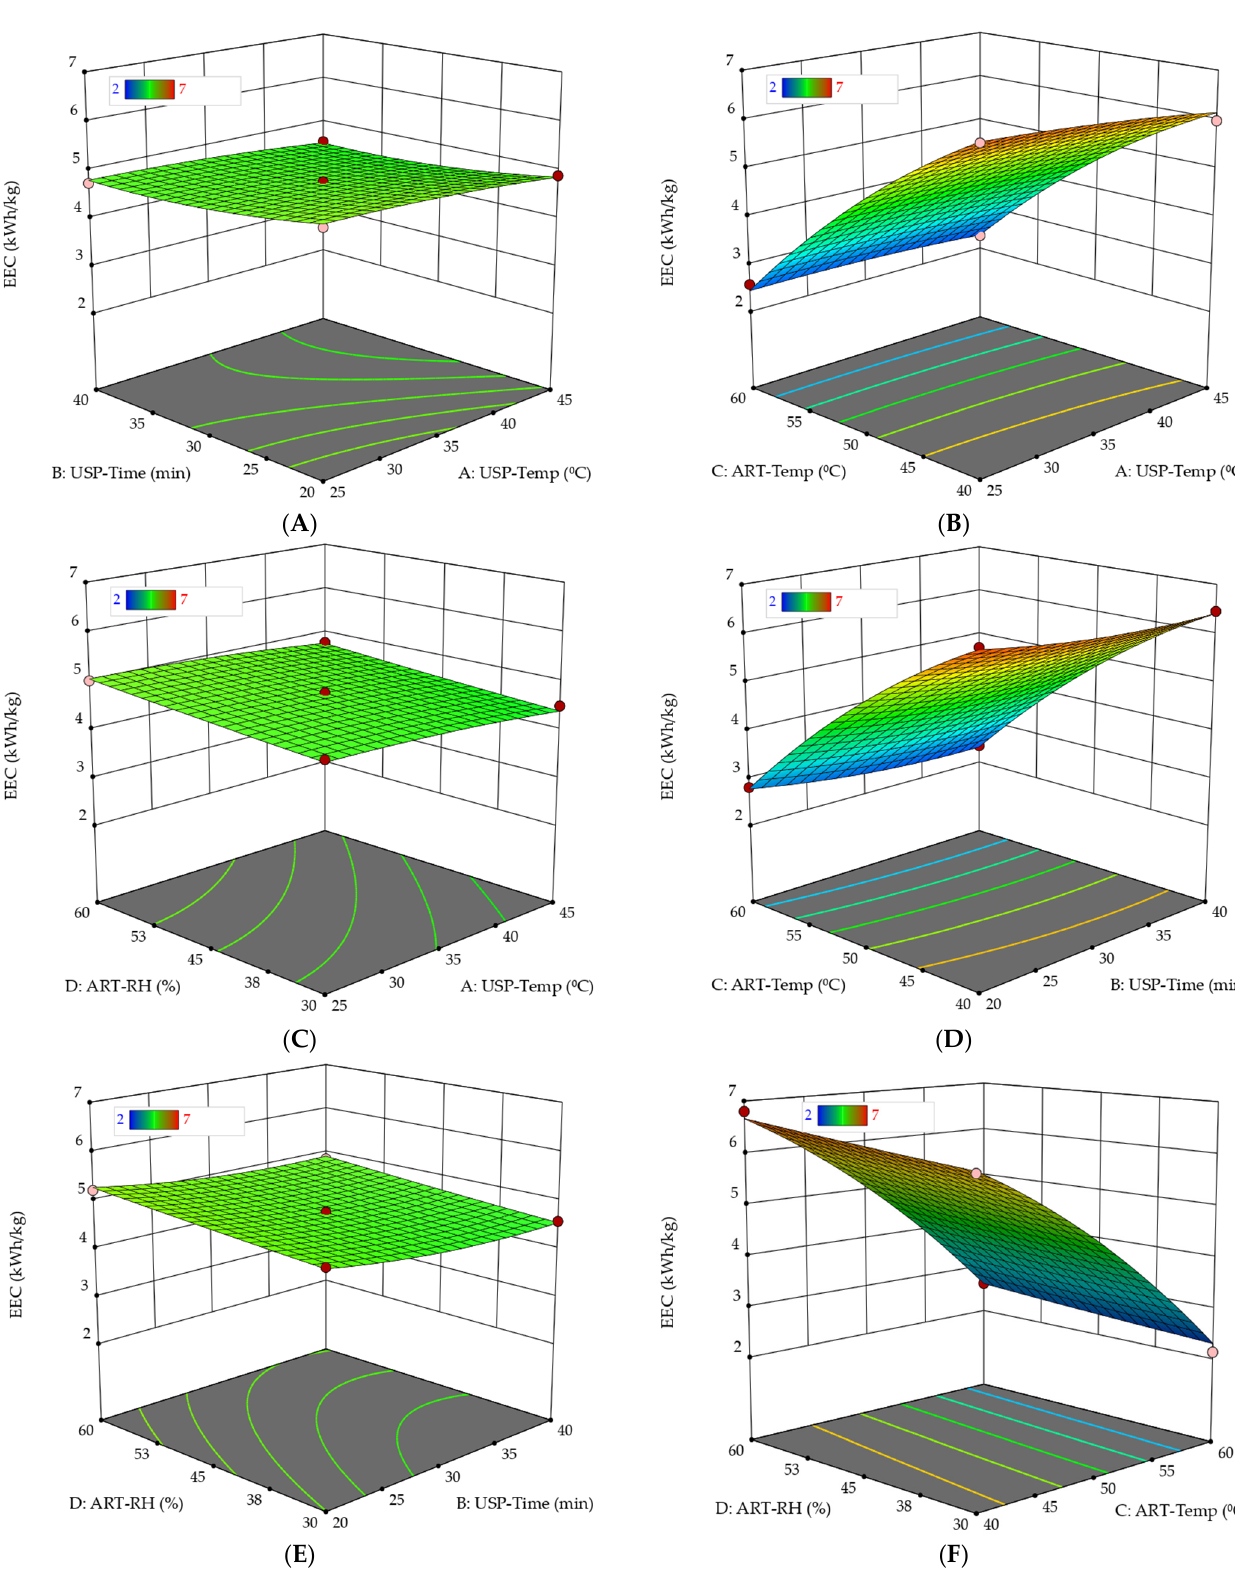
Figure 11. 3D response surface plots representing the effect of A: USP-Temp (ultrasound pretreatment time) and B: USP-Time (ultrasound pretreatment temperature) ( A ), A: USP-Temp and C: ART-Temp (ripening treatment temperature) ( B ), A: USP-Temp and D: ART-RH (ripening treatment RH) ( C ), B: USP-Time and C: ART-Temp ( D ), B: USP-Temp and D: ART-RH ( E ), C: ART-Temp and D: ART-RH ( F ) on the electrical energy consumption (EEC).